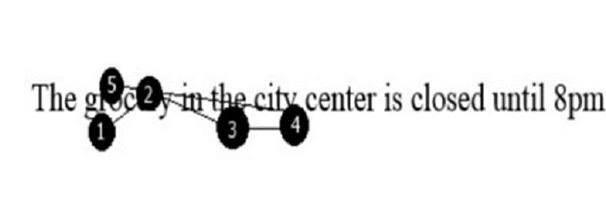
Figure 1. A scanpath